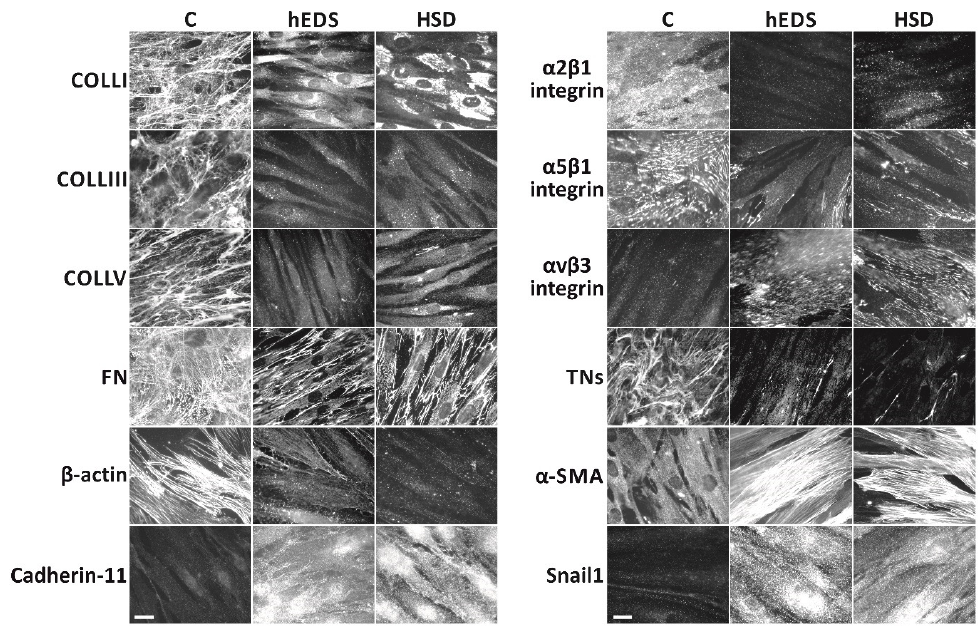
Figure 1. Widespread ECM disorganization and myofibroblast differentiation of hEDS and HSD cells. Control and patients’ cells grown on glass coverslips for 72 h were analyzed by IF with specific Abs directed against COLLI, COLLIII, COLLV, FN, TNs, α 2 β 1, α 5 β 1, and α v β 3 integrin receptors, β -actin, α -SMA, cadherin-11, and Snail1, as previously detailed [19,22,23]. The images are representative of 40 control and 20 hEDS and 20 HSD cell strains. Scale bar: 7 µm.